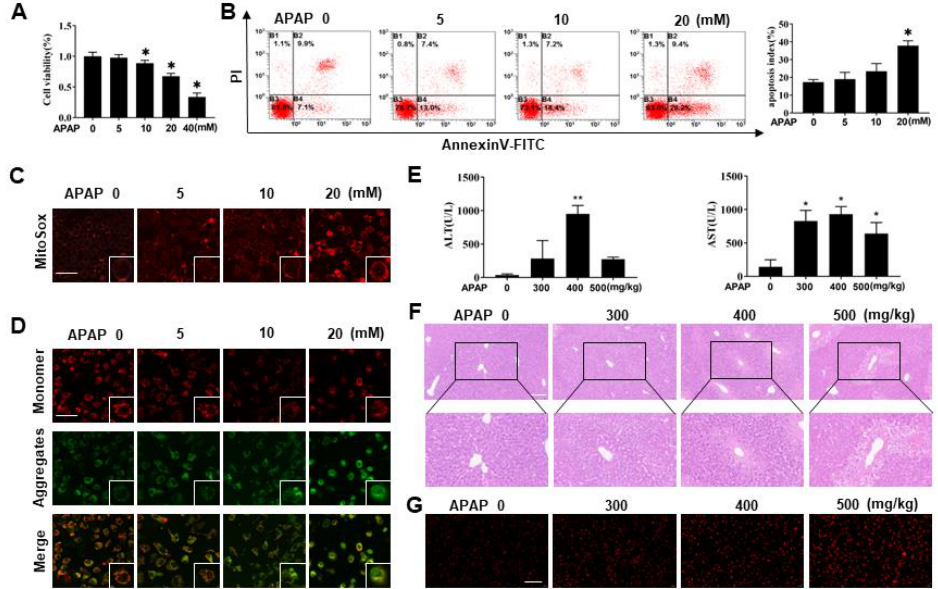
Figure 1. Establishment of the APAP acute liver injury model. ( A ) Changes in cell viability were measured after the L02 cells were treated with a gradient of concentrations of APAP, N = 6. * p < 0.05 vs. the Ctr group. ( B ) The apoptosis of L02 cells was detected by AnnexinV/PI double staining, N = 3. * p < 0.05 vs. the Ctr group. ( C ) The changes in mitochondrial ROS in L02 cells were detected by MitoSox staining, N = 3. ( D ) JC-1 staining was used to detect the change in mitochondrial membrane potential in L02 cells, N = 3. ( E ) Serum ALT and AST activities were measured in C57BL/6 mice treated with different doses of APAP, N=10. * p < 0.05 vs. the Ctr group, ** p < 0.01 vs. the Ctr group. ( F ) HE staining, N = 3. ( G ) Frozen sections of mouse liver tissue were stained with ROS staining solution to measure ROS changes, N =